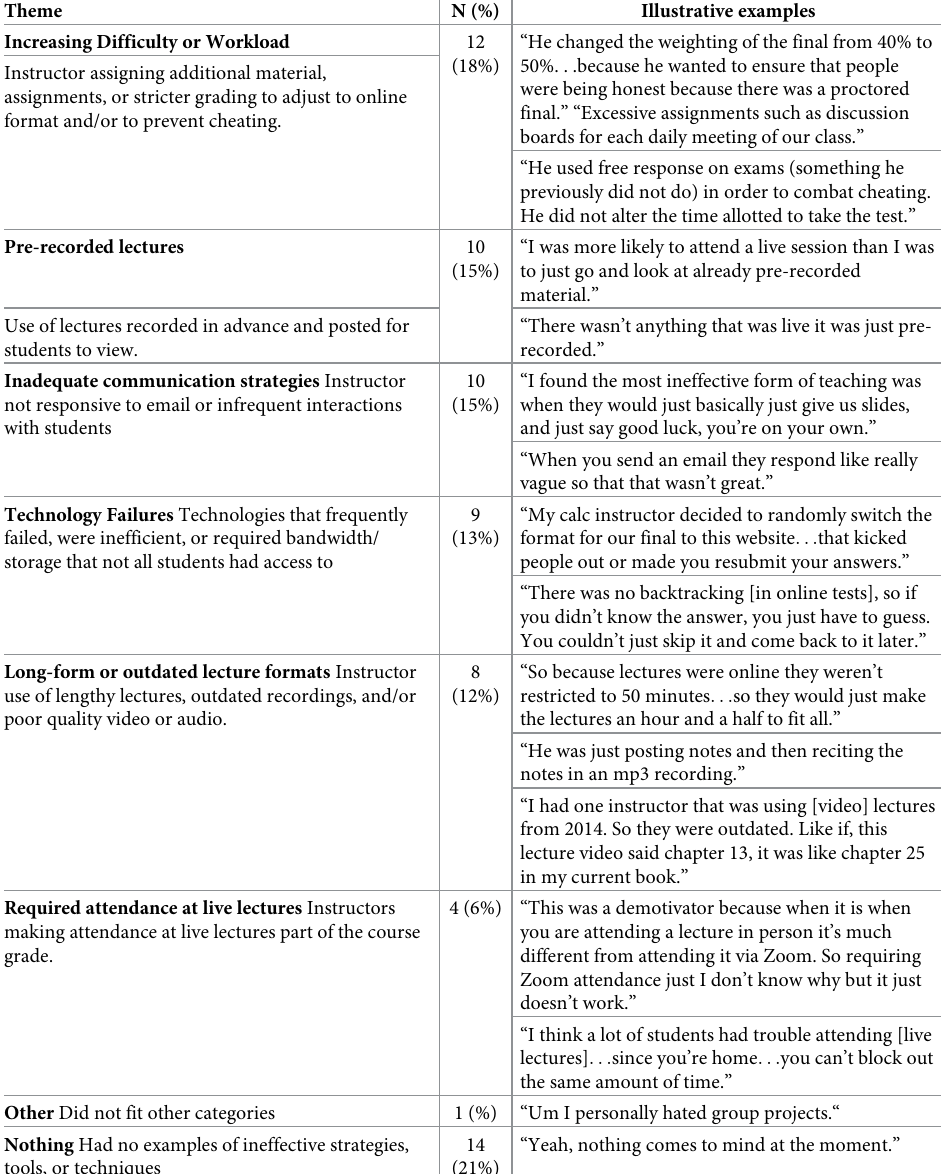
Table 4. Ineffective instructor strategies, tools, and technologies (N = 59; N = 68